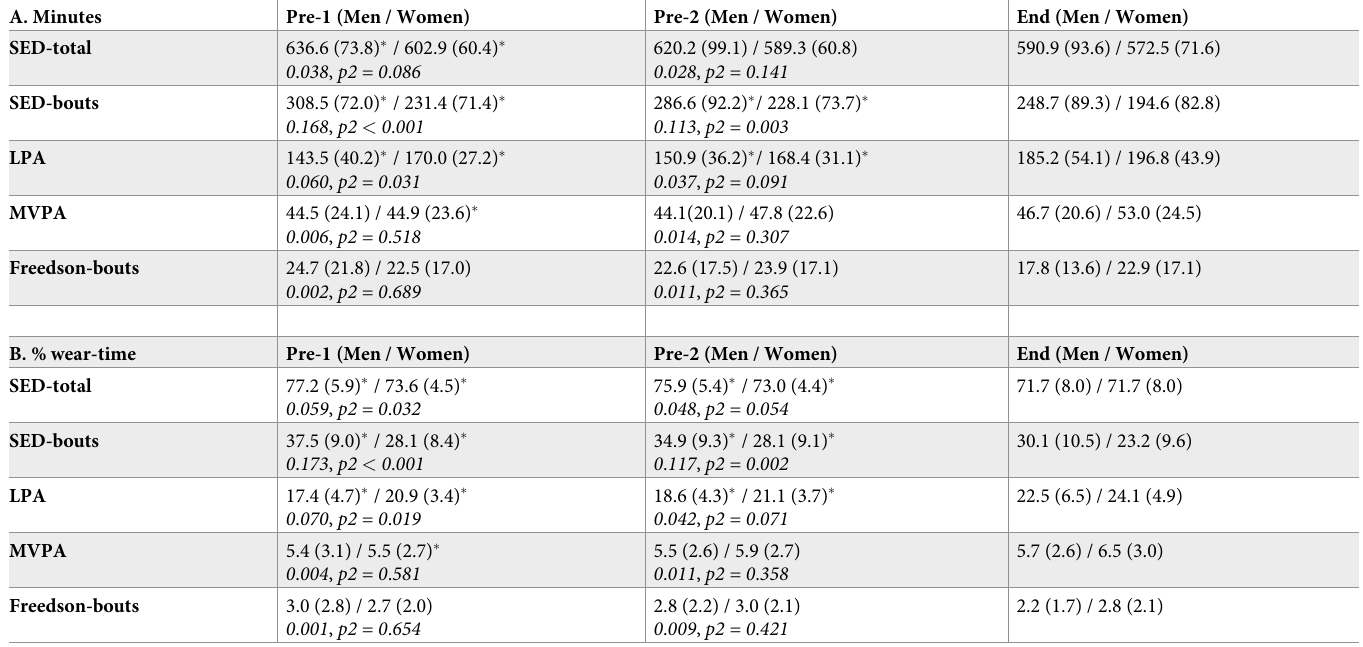
Table 4. Exercise group average values for men and women ( ± SD) in min/day (A-above) and in %-of-wear-time (B-below) for various accelerometer parameters. A significant difference ( p1 < 0.01) between End and either of the two pre-tests is marked at each pre-test with an asterisk ( � ) for both sexes. The effect size (ES) of the interac- tion effect comparing men versus women over time, measured with partial eta-squared with significance level ( p2- value) are presented below the average values for i) Pre-1 (for changes from Pre-1-to-End), and ii) Pre-2 (for changes from Pre-2-to-End). A.